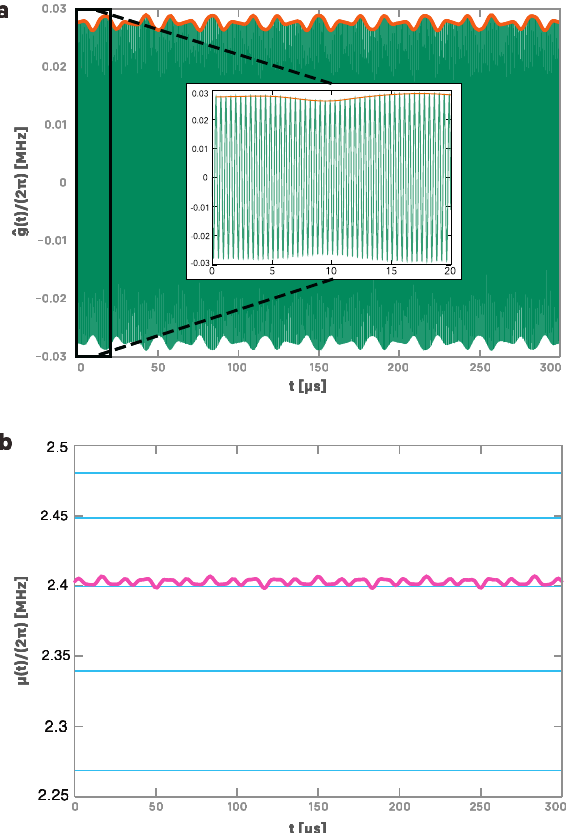
Fig. 3 Optimal τ = 300 μ s pulse function for a maximally entangling XX gate between ions i = 1 and j = 3, for fi ve ions with N A = 1000 basis states. The expansion coef fi cients A n of this pulse are shown in Fig. 2a. a The optimal pulse function ^ g ð t Þ (thin green line) with its amplitude function (thick orange line), obtained by demodulating ^ g ð t Þ as detailed in Supplementary Note 9. b Detuning function μ ( t ) obtained by frequency demodulating the pulse function, using the method described in Supplementary Note 9. The frequencies of the motional modes are shown as the fi ve horizontal lines. The sample motional-mode frequencies used to generate this pulse are listed in Supplementary Table 1 and the set of η parameters used are listed in Supplementary Table 2 in Supplementary Note